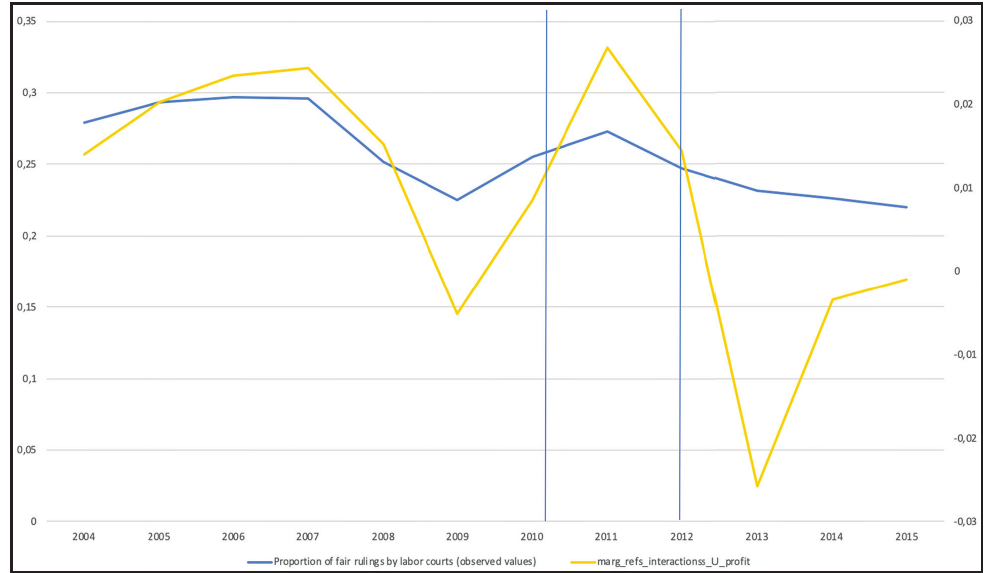
Figure 4 Marginal effect of reforms, unemployment, and profitability on labor court rulings declaring dismissals/layoffs as